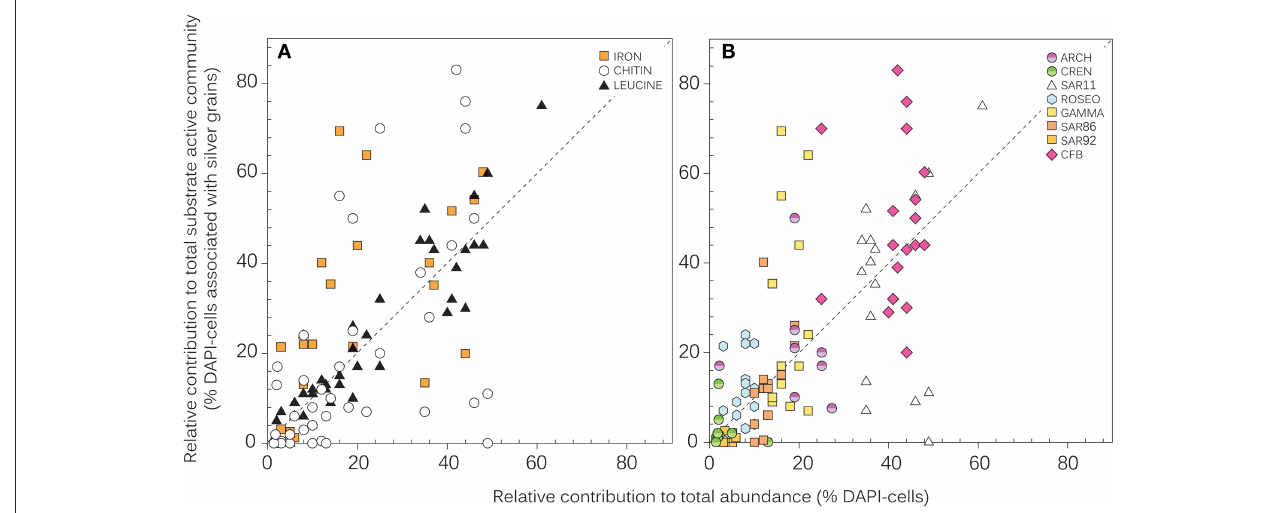
FIGURE 3 | Relationship between the relative contributions of prokaryotic groups to total abundance (% DAPI-cells) and to the total substrate active community (% DAPI-cells associated with silver grains) for the three substrates (A) and for different bacterial groups (B) . All stations are pooled. Pearson correlations between the relative contributions to abundance and to the total substrate active community are respectively r = 0.93 ( p < 0.00001), r = 0.51 ( p < 0.001), and r = 0.26 ( p > 0.05) for leucine, chitin, and iron. The dotted line indicates the 1:1 ratio. ARCH, Archaea; CREN, Crenarchaeota; CFB, Cytophaga/Flexibacter/Bacteroides; ROSEO, Roseobacter clade; SAR11, SAR11 cluster; SAR86, SAR86 cluster; SAR92, SAR92